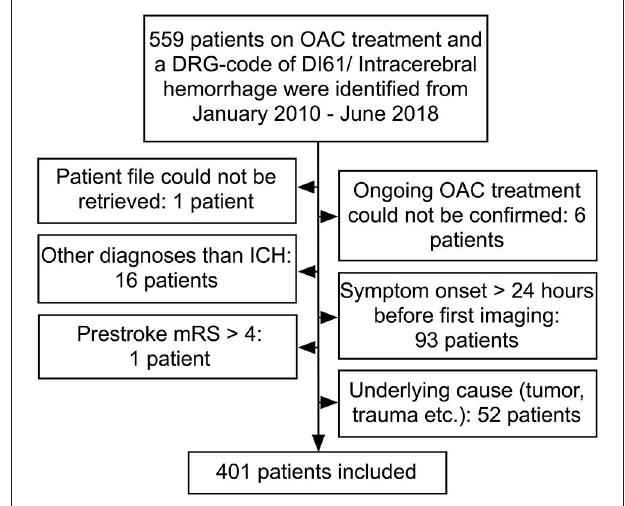
FIGURE 1 | Patient flow. Patients may be counted more than once, if they fulfilled more than one exclusion criteria. OAC, oral anticoagulant; ICH, intracerebral hemorrhage; mRS, modified Rankin